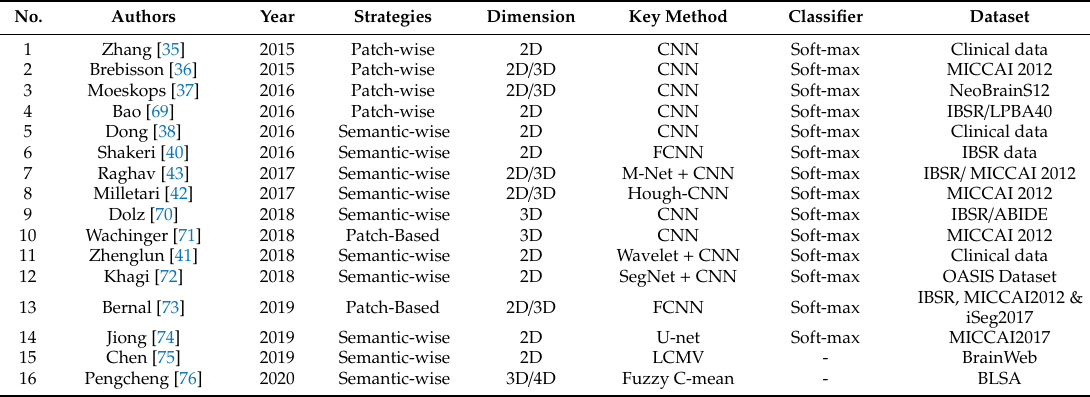
Table 3. The brain structure segmentation methods based on deep learning.